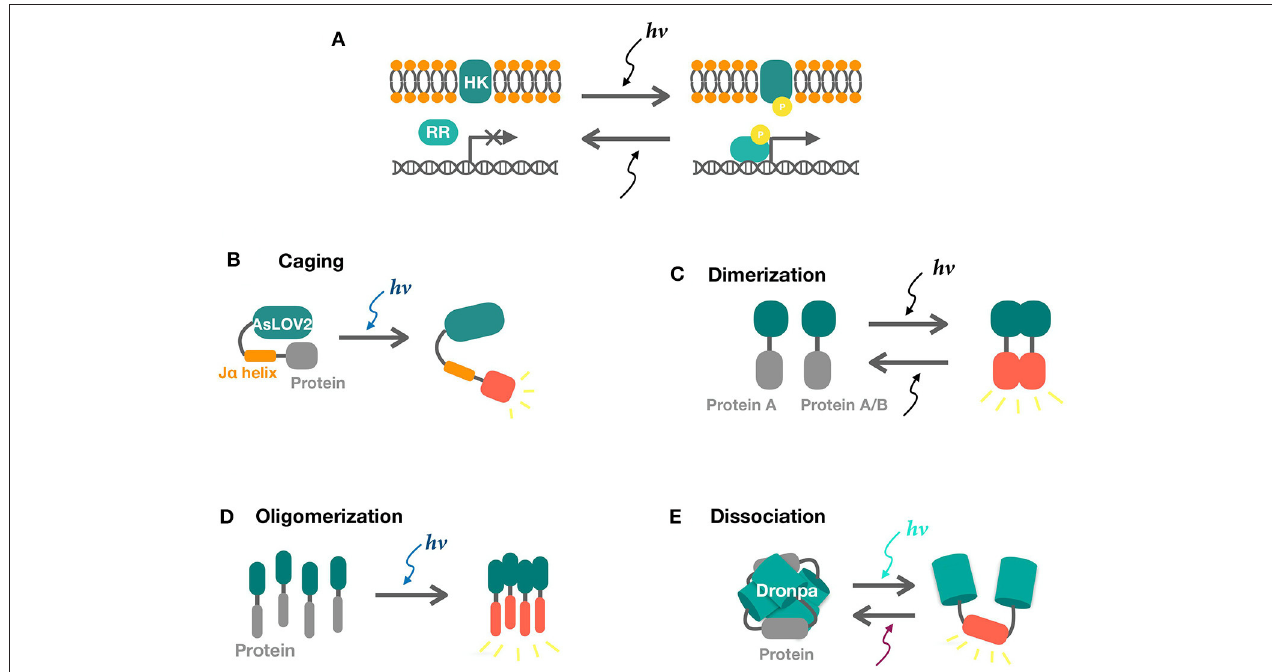
FIGURE 1 | Schematics of two-component and one-component systems. (A) Two component systems consist of a sensor histidine kinase (HK) and a response regulator (RR). Activities of response regulators for transcription are tuned by phosphate signaling upon light illumination. (B) Photo-induced LOV2-J α dissociation uncages the fused protein in response to blue light, releasing its activity. (C,D) Light-induced dimerization and oligomerization of sensors result in the interaction of the attached proteins. (E) Photo-induced dissociation of Dronpa tetramer releases the protein of